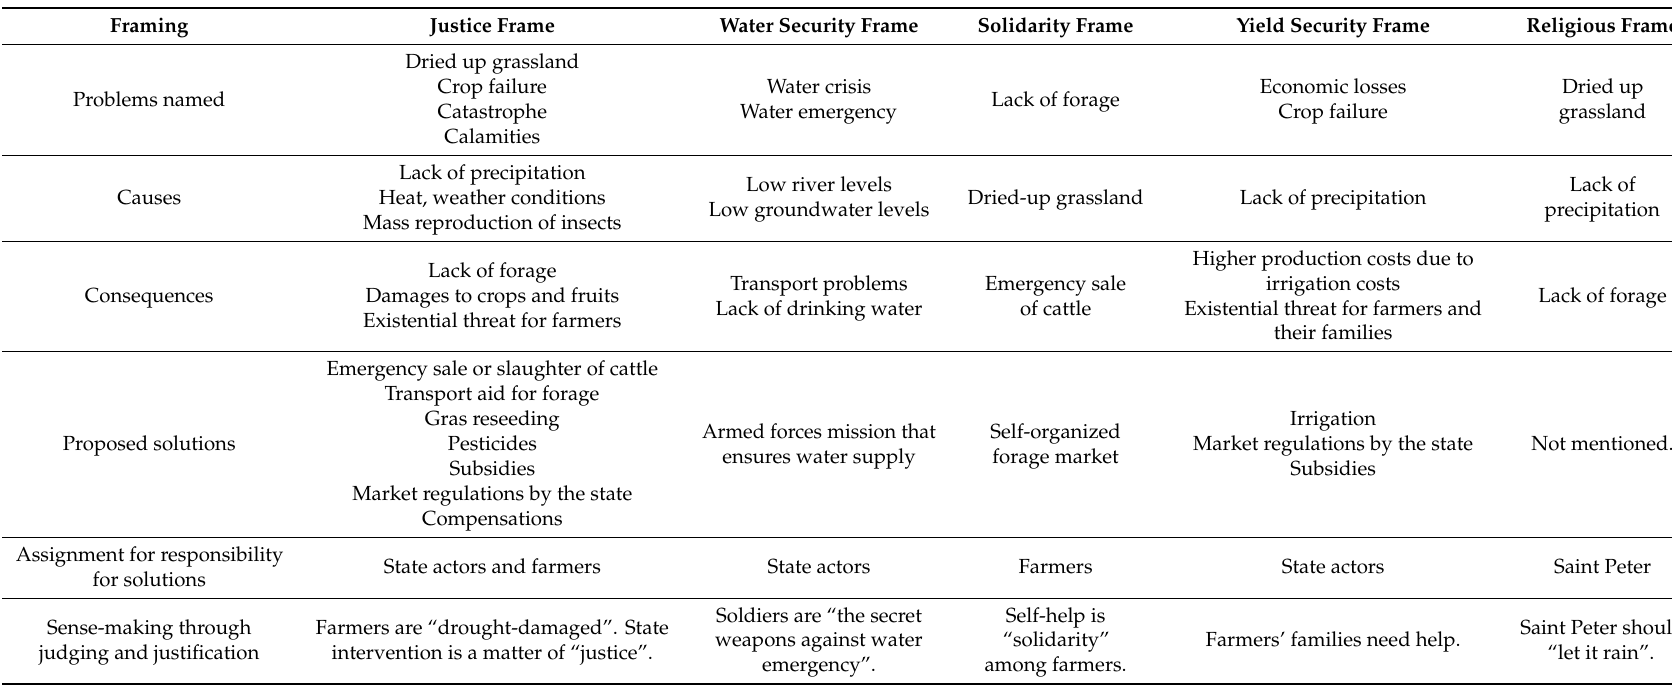
Table 2. Framing of drought by farmers in Baden-Württemberg 1975-80. Context: The period 1975–80 was strongly characterized by an election campaign in 1976. The parliamentary elections took place on 3rd October